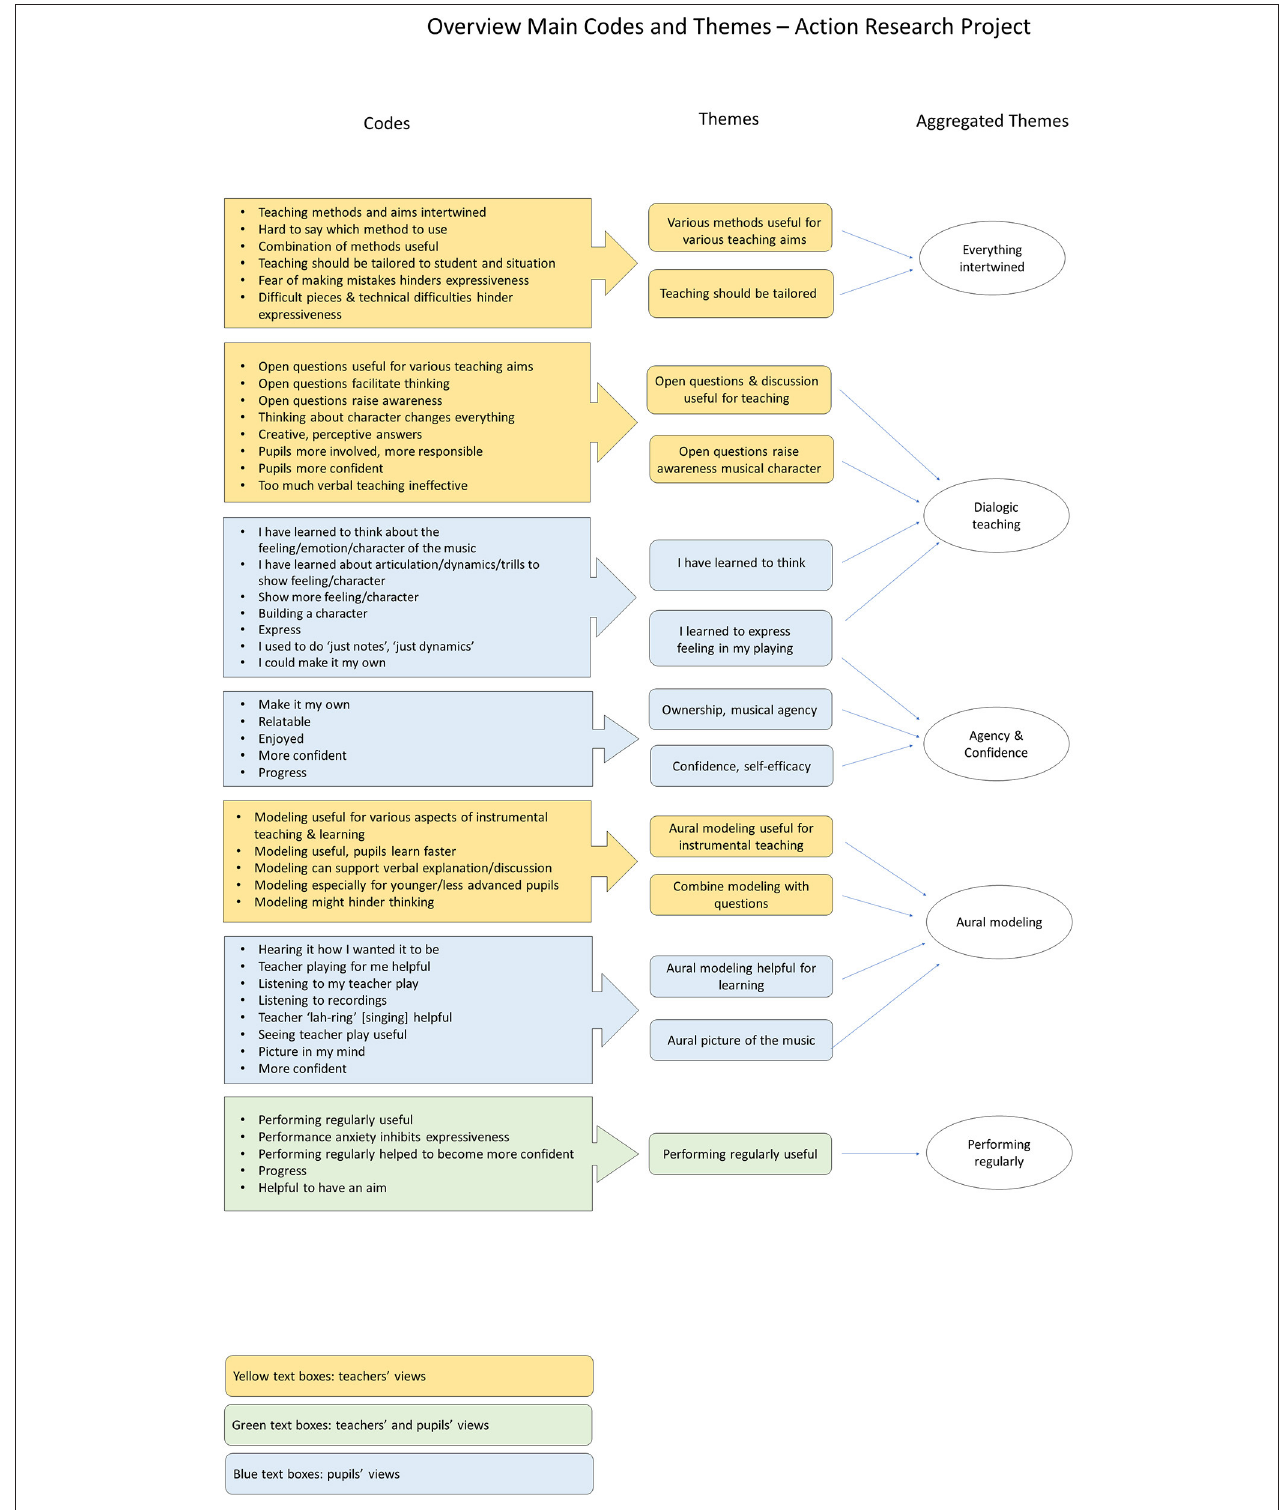
FIGURE 3 | Data structure containing an overview of the main codes and themes.